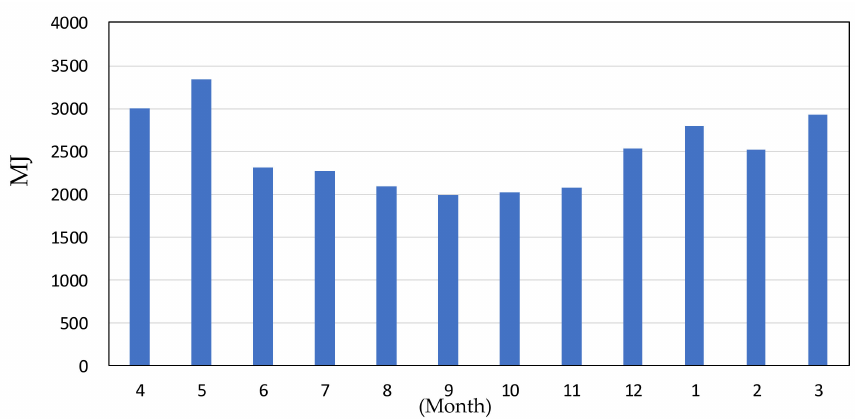
Figure 12. Heat generation by hydrogen fuel cell